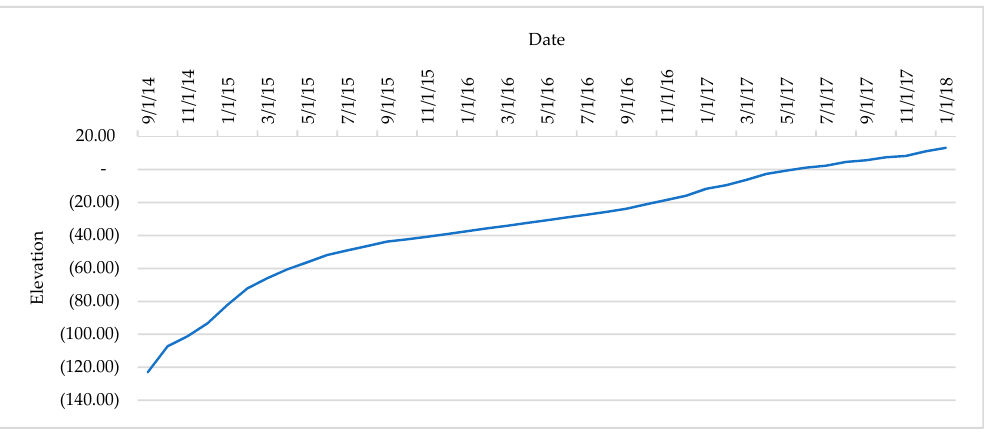
Figure 10. Water level.